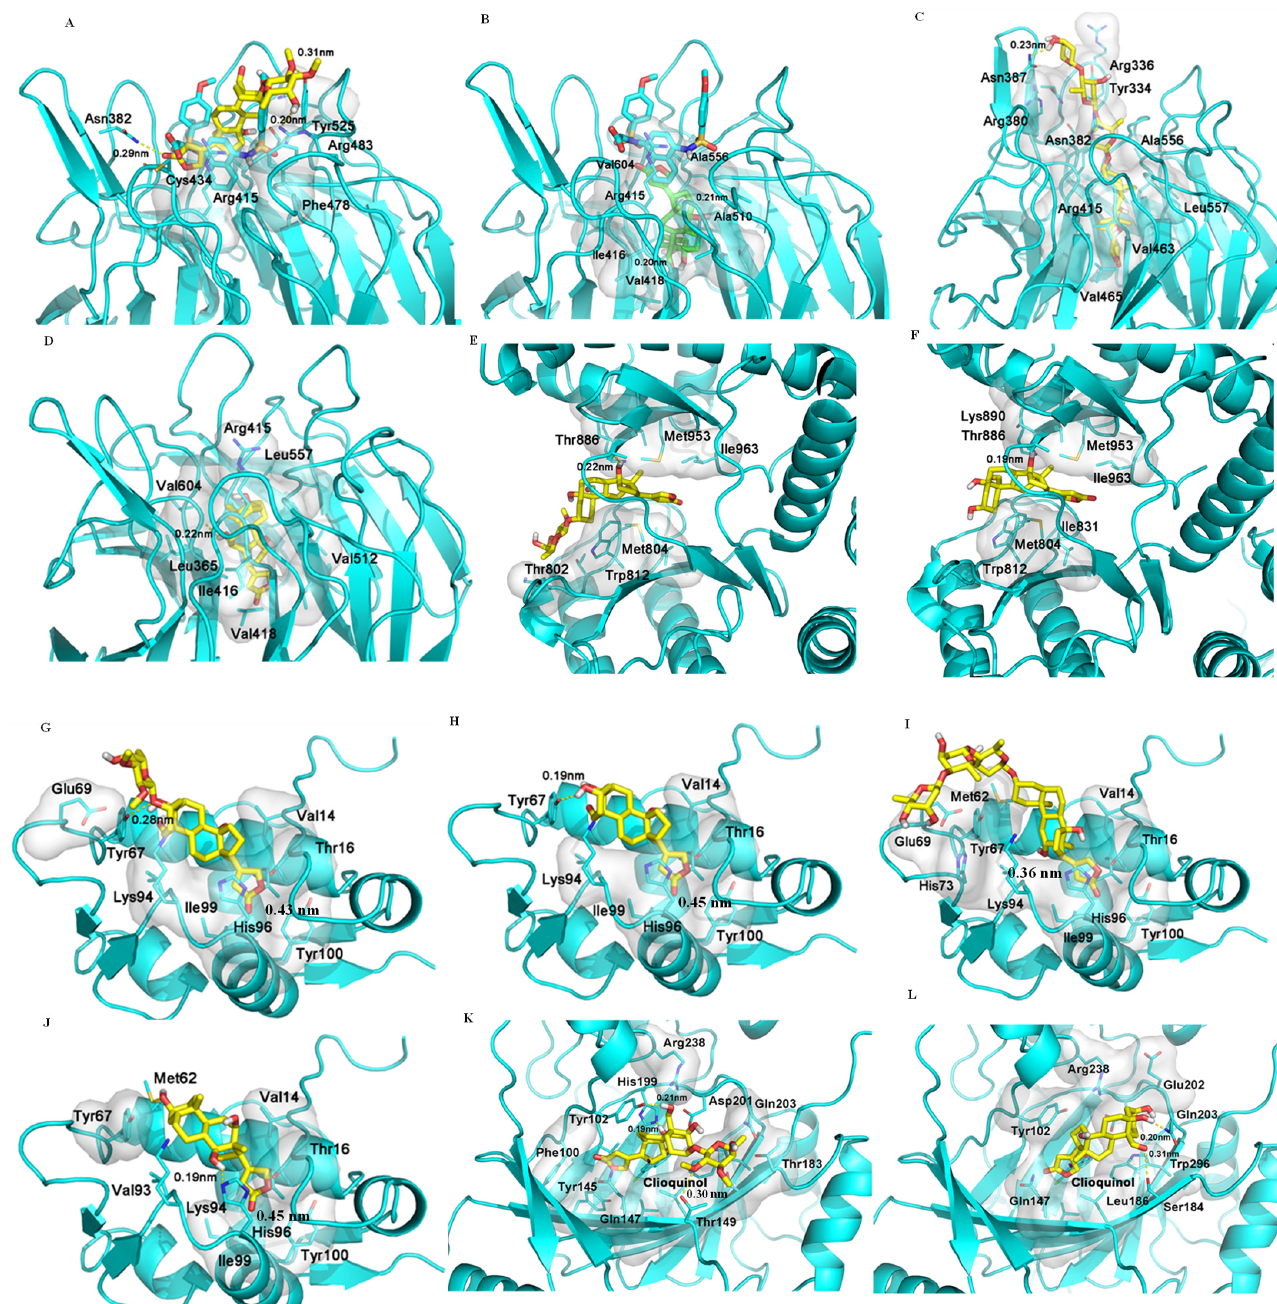
Figure 2. Docking profiles for (+)-strebloside ( 1 , A ), strophanthidin ( 10 , B ), digoxin ( C ), and digoxigenin ( D ) and KEAP1 (PDB entry 6V6Z), for 1 ( E ) and 10 ( F ) and PI3K (PDB: 6AUD), for 1 ( G ), 10 ( H ), digoxin ( I ), and digoxigenin ( J ) and MDM2 (PDB entry 4HBM), and for 1 ( K ) and 10 ( L ) and FIH-1 (PDB entry 3KCX). AutoDock Vina was used to generate the docking profiles, and the crystal structures of the target proteins were obtained from the Protein Data Bank (PDB) and employed as the receptors for the docking with 1 , 10 , digoxin, and digoxigenin [14], with the interaction distances being in the